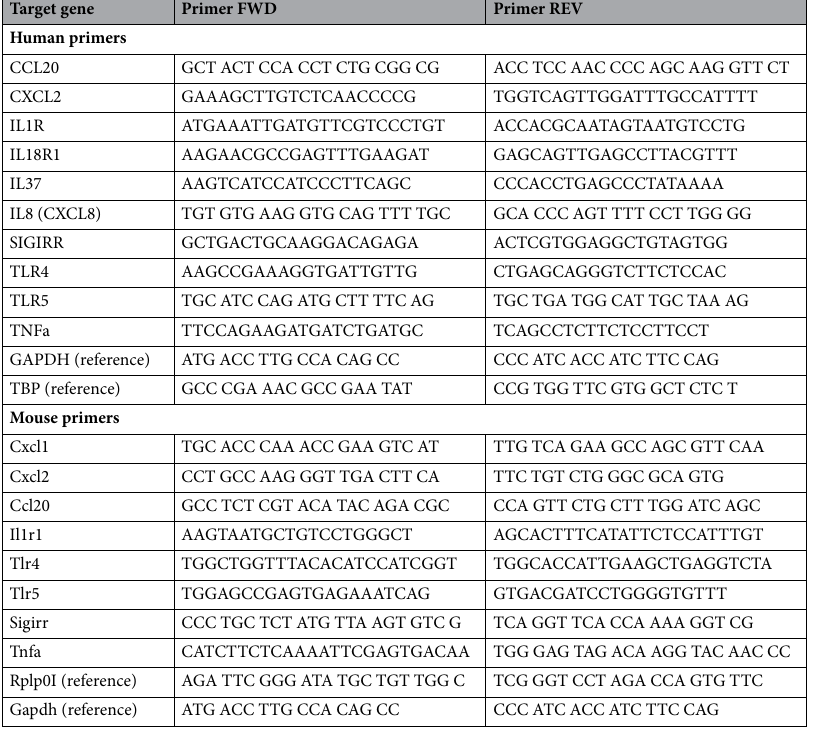
Table 1. Primer list for qPCR